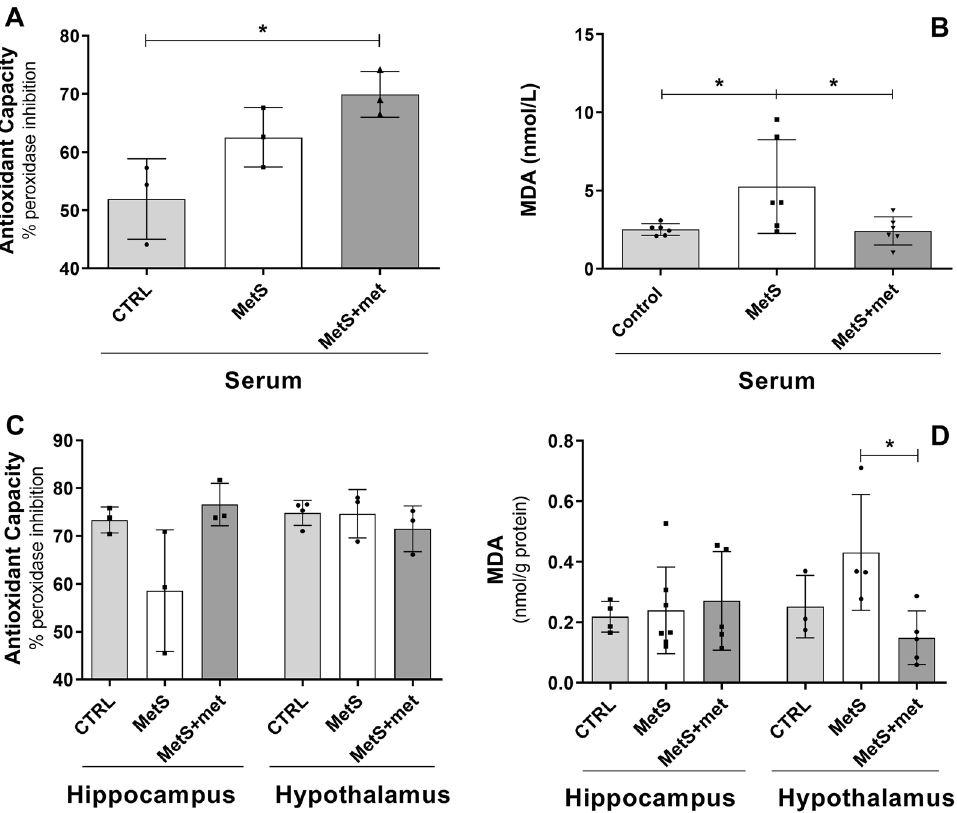
Figure 4. Effect of the metabolic syndrome (MetS) and metformin on oxidative stress. ( A , B ) Serum antioxidant capacity and lipid peroxidation. ( C , D ) Brain tissue (hippocampus, hypothalamus) antioxidant capacity and lipid peroxidation. The data represent the mean ± SD. Sample size (N) serum and hippocampal antioxidant capacity CTRL = 3, MetS = 3, MetS + met = 3; for serum lipid peroxidation CTRL = 6, MetS = 6, MetS + met = 6; hypothalamic antioxidant capacity CTRL = 4, MetS = 3, MetS + met = 3; hippocampal lipid peroxidation CTRL = 4, MetS = 7, MetS + met = 5; hypothalamic lipid peroxidation CTRL = 3, MetS = 4, MetS + met = 5. *p ≤